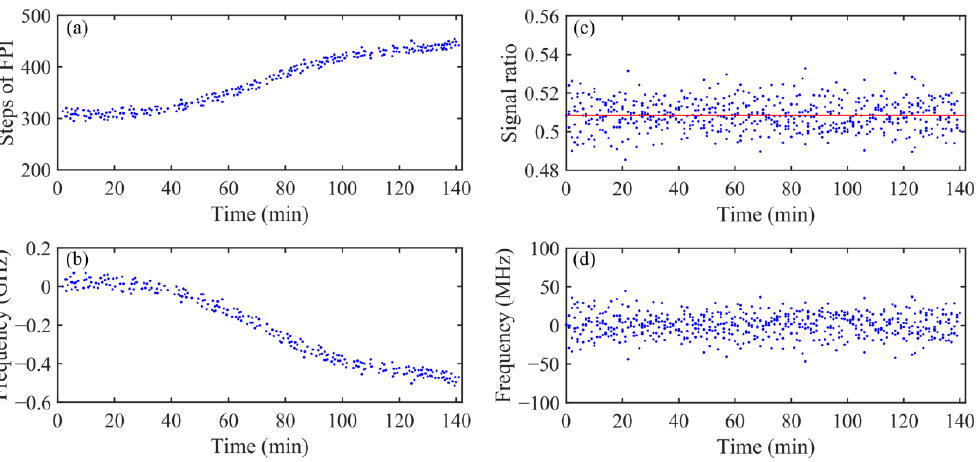
Figure 6. ( a ) The movement of FPI steps in a frequency locking process; ( b ) the equivalent frequency adjustment of FPI; ( c ) the locked signal ratios, accompanied by the reference ratio of 0.508 (red line); ( d ) the final frequency variation.